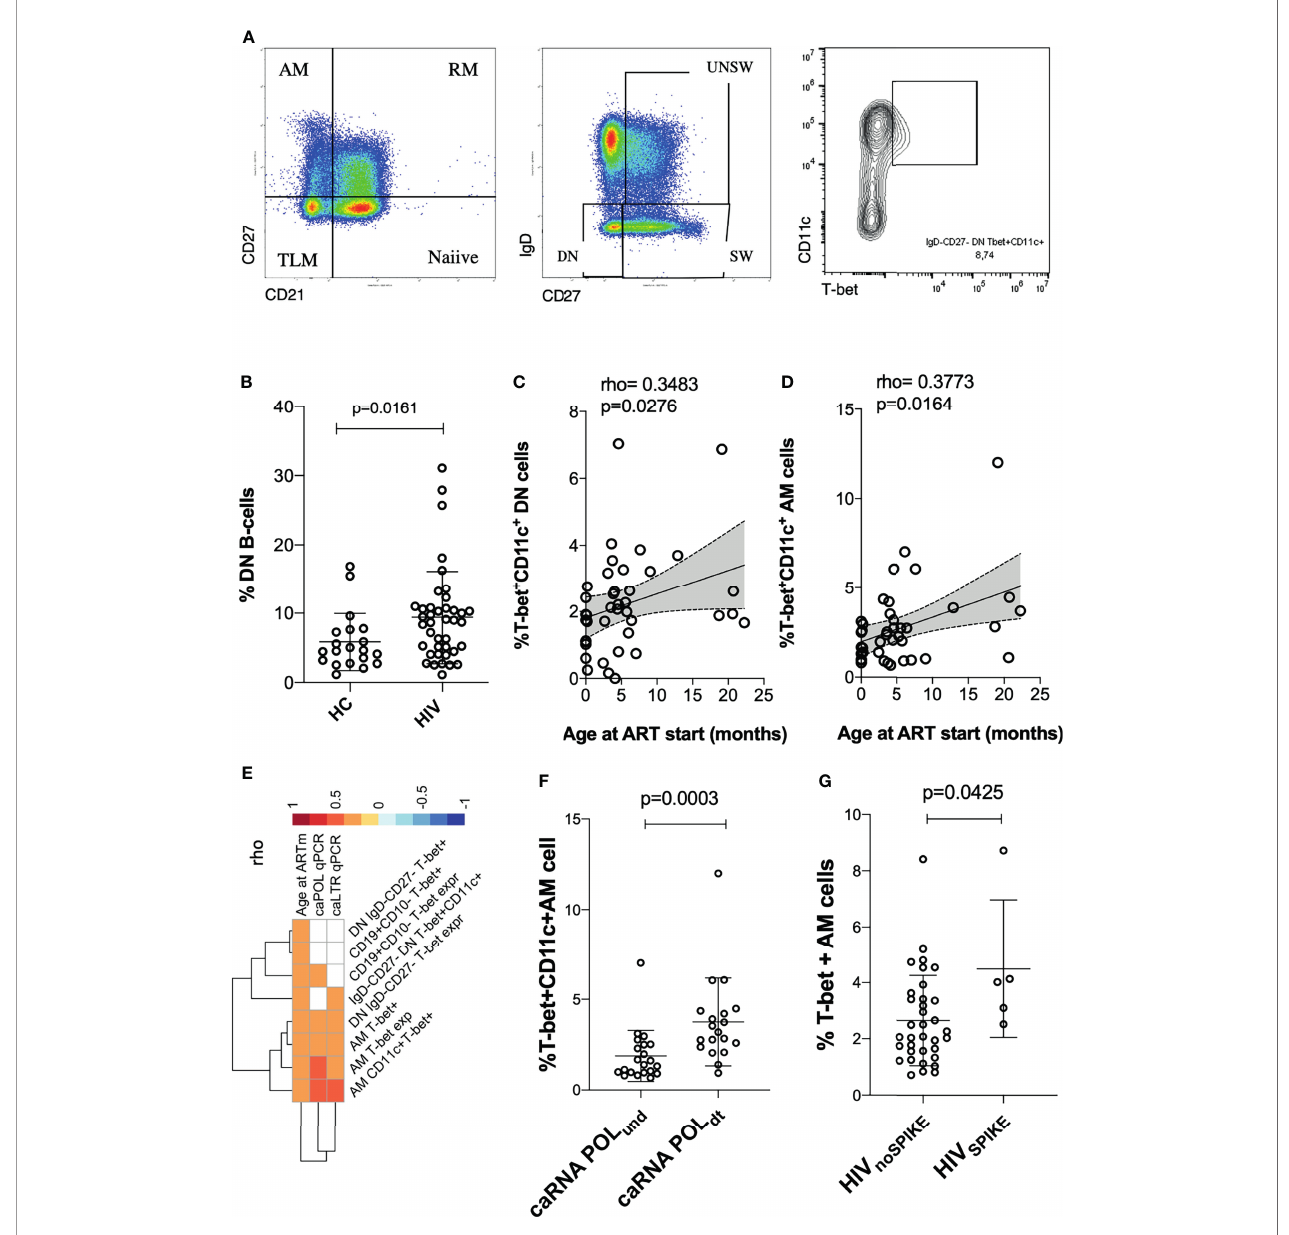
FIGURE 1 | Time of ART initiation and cell associated HIV-1 RNA (caRNA) are associated with phenotypic signs of B cell hyperactivation. Gating strategy is shown in (A) ; in (B) showed levels of DN in adolescents with perinatally aquired HIV-1 (HIV) and healthy controls (HC); (C, D) correlations between ABCs cells and age at ART start are shown; (E) correlation plot between viral correlates of recent replication and ABCs / exhausted T-cells are shown; differential analysis between levels of ABCs cells and caRNA or SPIKE being detected vs non-detected is shown in (F, G) . p values are calculated using Mann Whitney test in (B, F, G) . Spearman p values are shown in (B – D) . Signi fi cance was set at p>0.05. DN, double negative; AM, activated memory; SW, Switched B-cells (memory B-cells); UNSW, Unswitched B-cells; MFI, mean fl uorescent